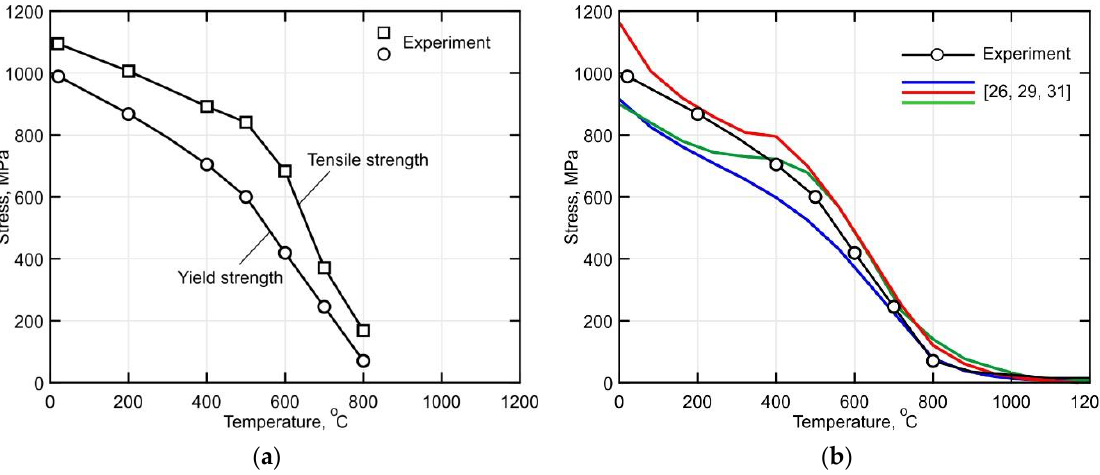
Figure 11. ( a ) Yield and tensile strength of the Ti-6Al-4V alloy as functions of temperature and ( b ) comparison of the obtained yield strength with published data from [26,29,31].